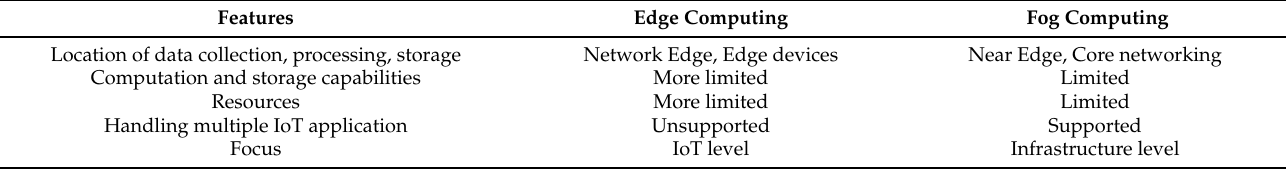
Table 1. Comparison of Fog and